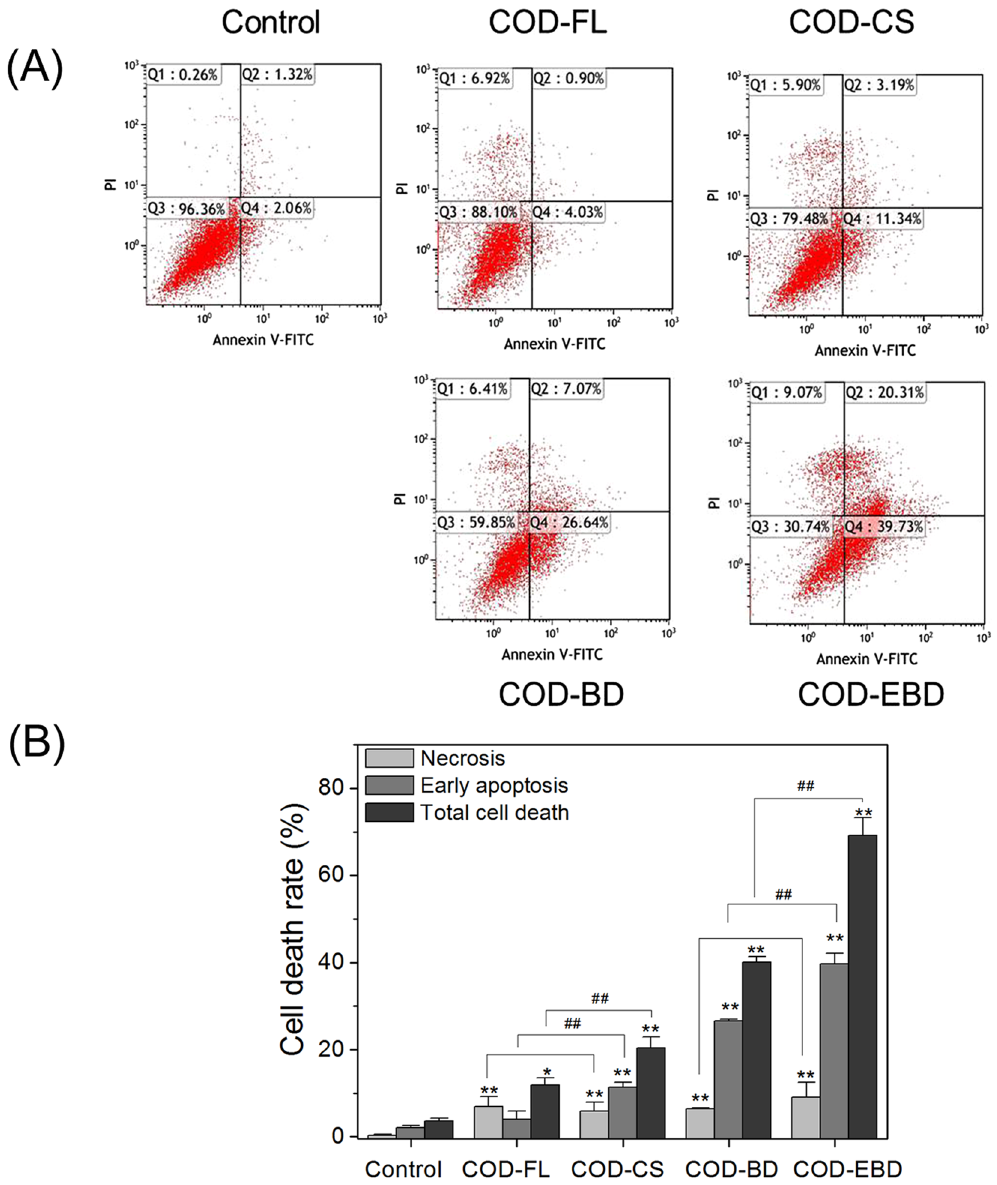
Figure 7. Cell death of HK-2 cells after exposure to varying shapes of COD crystals for 12 h. ( A ) The representative dot plot of apoptosis and necrosis. Quadrant Q1, Q2, Q3 and Q4 denote the ratio of necrotic cells, late apoptotic cells and/or necrotic cells, normal cells, and early-stage apoptotic cells, respectively. ( B ) Quantitative results of apoptosis and necrosis. Crystal concentration: 400 μ g/mL. Compared with control group, * p < 0.05. ** p < 0.01. COD-FL treatment group vs corresponding concentration of COD-CS treatment group, COD-BD treatment group vs corresponding concentration of COD-EBD treatment group, # P < 0.05, ## P <